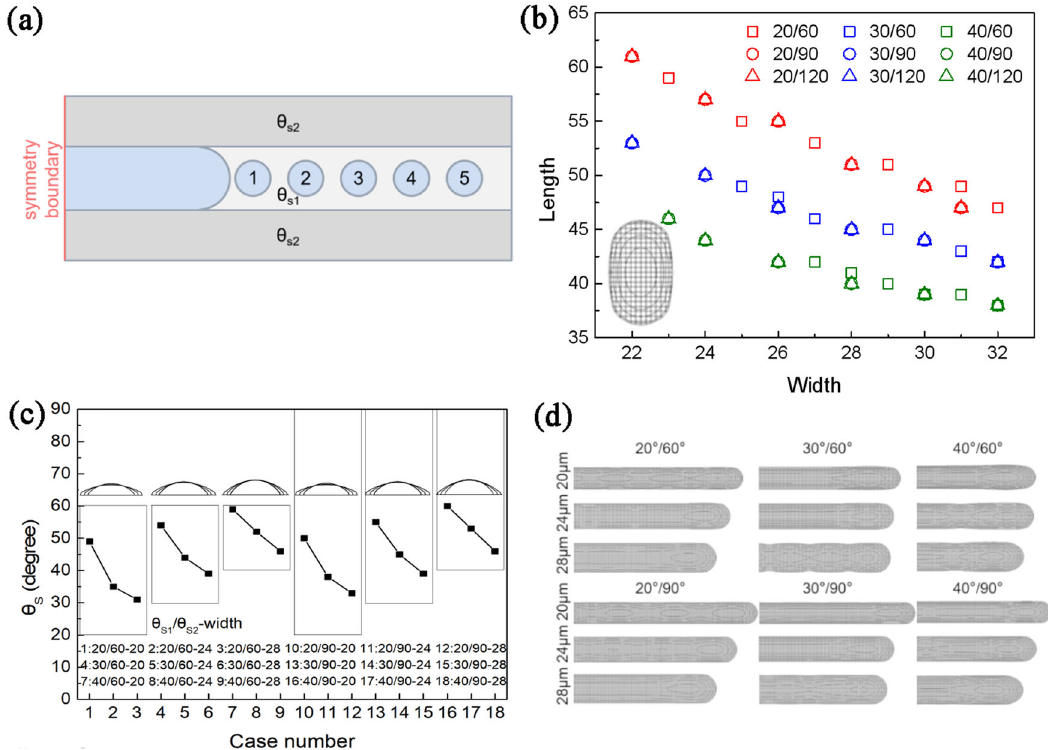
Fig. 8 Simulation of selective treatment. a Schematic diagram of printing with selective treatment. b Simulated single droplet scales of different cases. c Macroscopic contact angle and cross-section shape of different cases. d Simulated multidroplet morphology of different cases. a Is the top view of the computational region to realize selective treament, the contact angle of different regions are shown in the fi gure and droplets are deposited by the numerical order. In b , the number/number mean θ and length of single droplet in different selective treatment conditions. In c , the number/number-number of different cases mean θ s1 / θ s2 - width of θ s1 region, and the vertical coordinate is the macroscopic contact angle, and d shows the top view of simulated